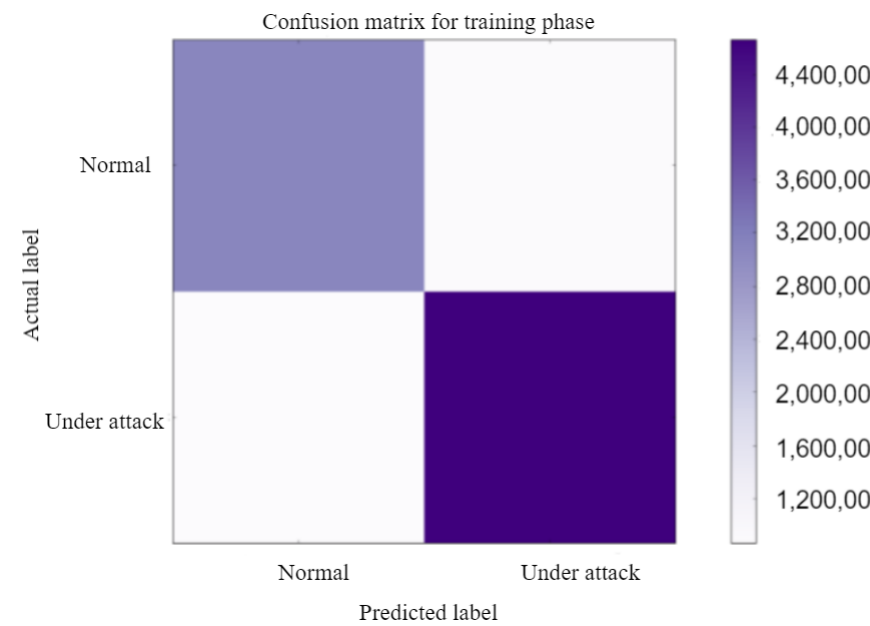
Figure 11. Confusion